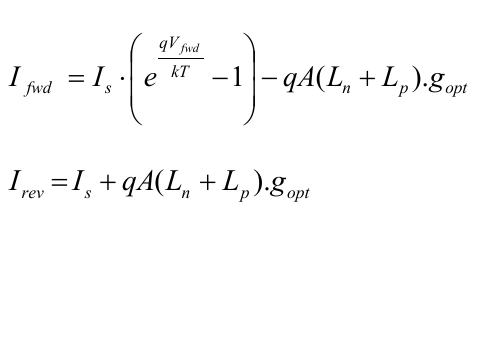
Figure 2. The produced electron-hole pairs within the depletion layer width or within the minority carrier diffusion lengths at either side of the junction (process II the build-in electrostatic potential, as shown by the small arrows for electrons in the conduction band and holes in the valence band. On the other hand, the electron-hole pairs induced by absorbed photons outside the aforesaid region (process I by the electrostatic field and once, the carriers lifetime has elapsed, they will recombine spontaneously, emitting photons having a total energy equal to the energy gap, E (process I b